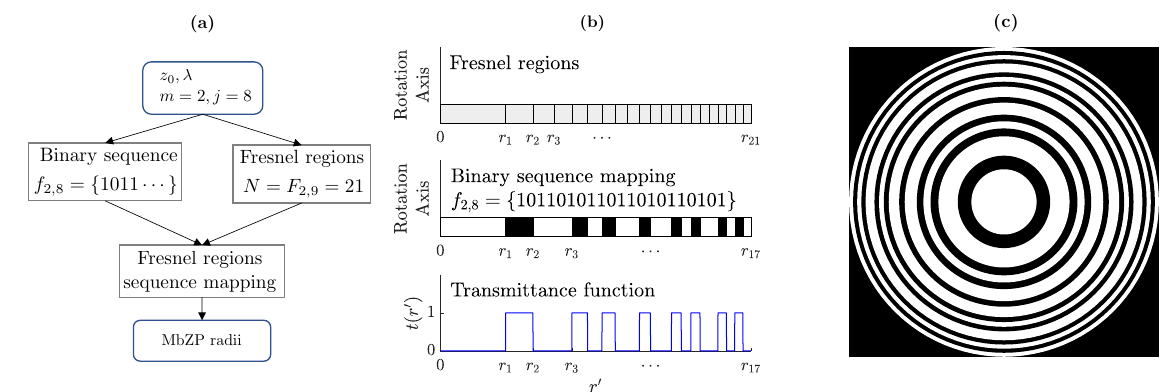
Figure 1. Lens design procedure with m = 2 and j = 8: ( a ) design steps; ( b ) Fresnel regions (top), classification of M-bonacci Zone Plate (MbZP) regions after the binary sequence mapping (middle) and final transmittance function of the lens (bottom); and ( c ) resulting MbZP